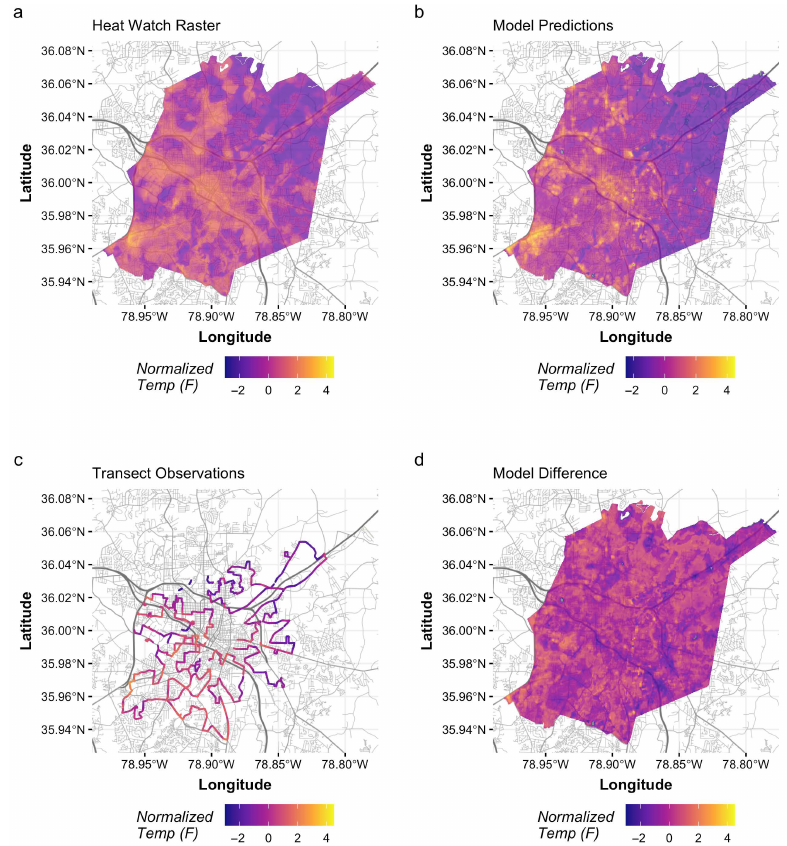
Figure 4. Normalized estimated temperatures from Heat Watch for 23 July 2021 [49] ( a ) versus July model predictions ( b ) for Durham, North Carolina. Heat Watch transect routes are mapped in ( c ) and differences between models in ( d ).